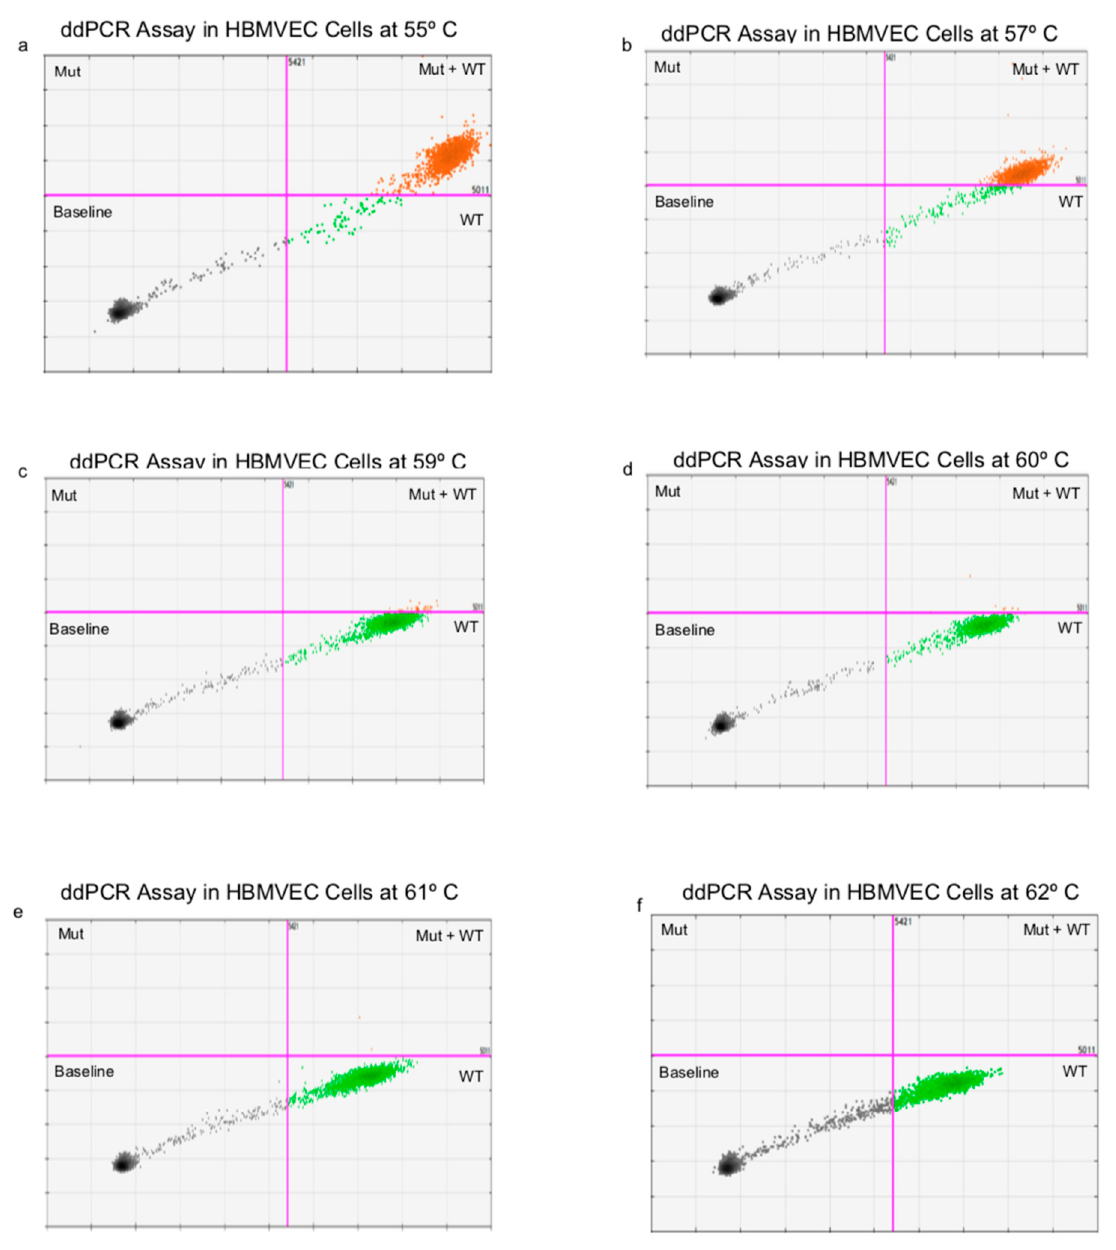
Figure A1. ddPCR 2D Plots of Temperature Gradient in HBMVEC Cell Line. Plots with wild type channel amplitude ( x -axis) and mutant channel amplitude ( y -axis) at 55 ( a ), 57 ( b ), 59 ( c ) 60 ( d ), 61 ( e ), and 62 °C ( f ) in HBMVEC cells with the universal primer are shown.